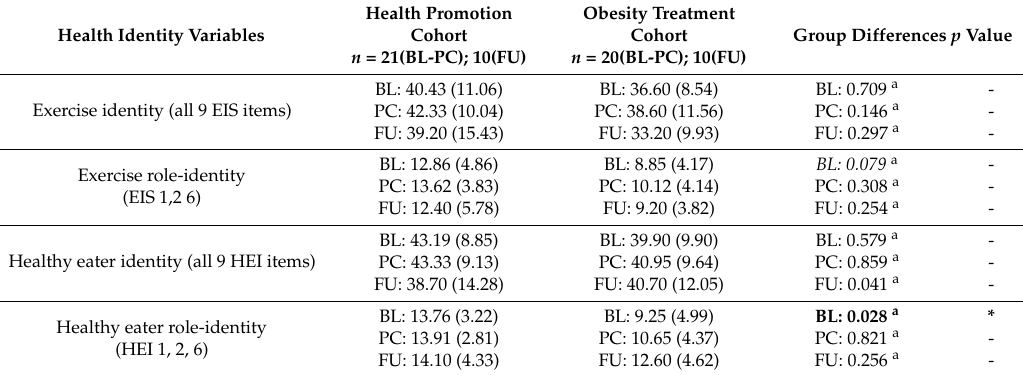
Health Identity